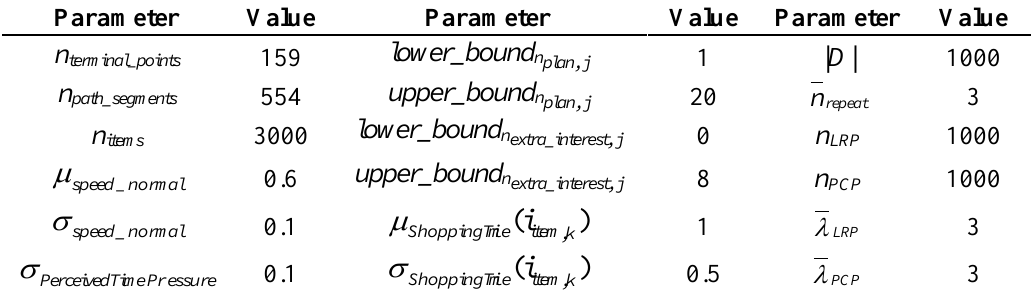
Table 5. Default values of various parameters used in our simulations.